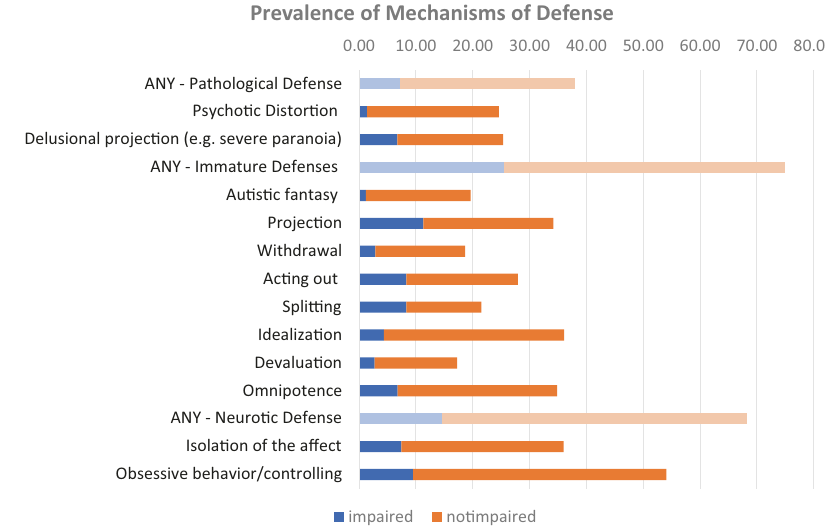
Fig. 1 Prevalence of mechanisms of defense in the National Epidemiological Survey on alcohol and related